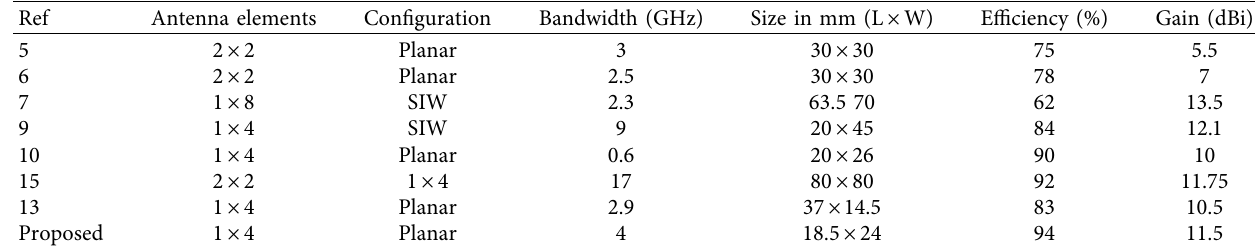
Table 1: Comparison table of proposed antenna with published literature.